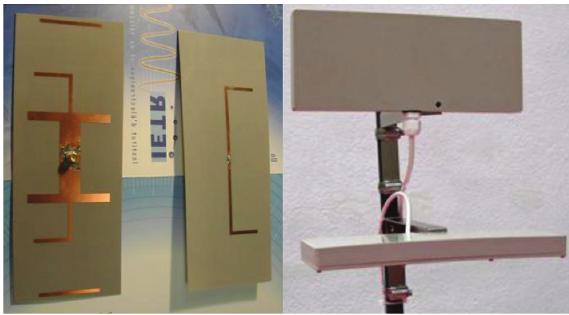
Figure 16: Photo of the dual-beam printed dipole antenna.